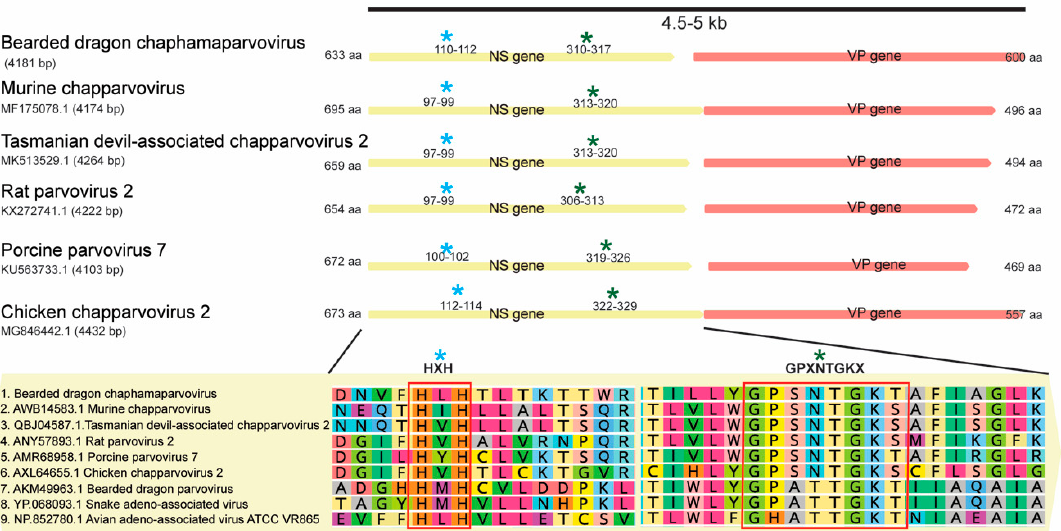
Figure 3. Genome of bearded dragon chaphamaparvovirus in comparison to related viruses. The amino acid sequence size of the ORFs of each virus is shown. Yellow and orange boxes refer to the NS and VP genes, respectively. The classic motif features HXH (blue asterisk) and GPXNTGKX (green asterisk) on NS genes are labelled.